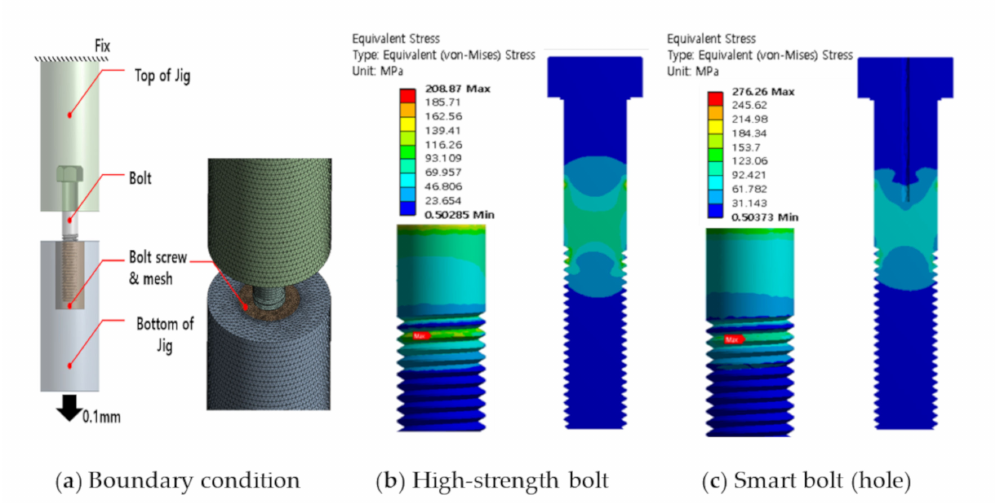
Figure 3. Finite element analysis of the smart